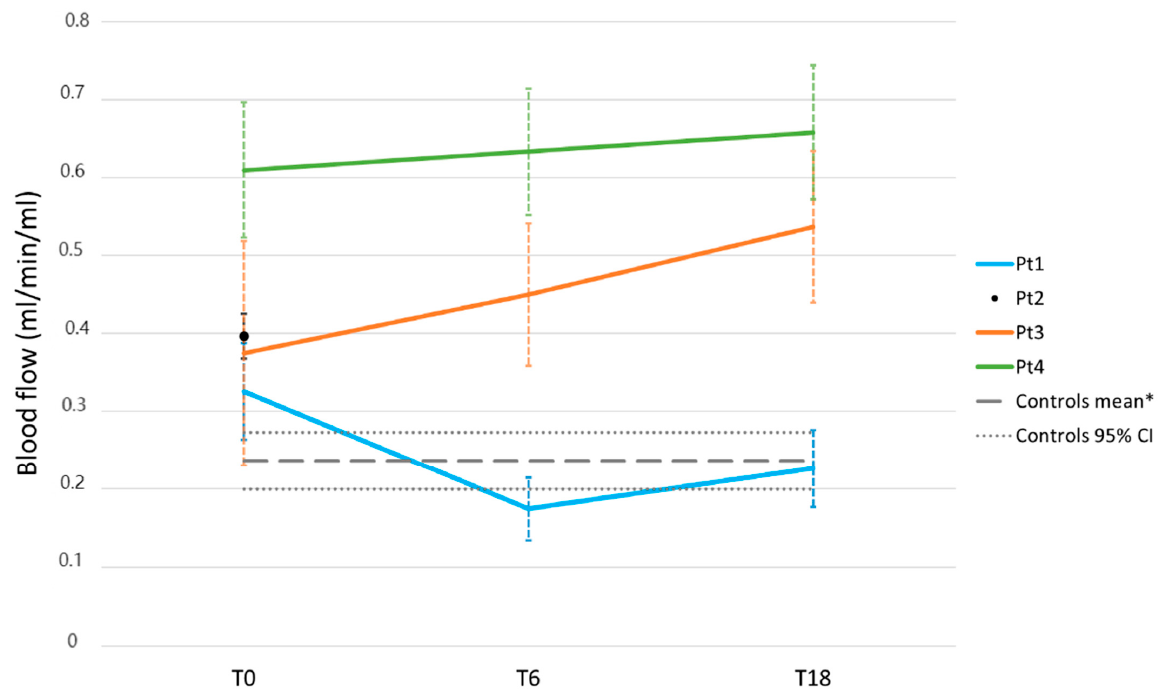
Figure 5. Blood flow as measured by [ 15 O]water PET. The mean vertebral blood flow (+/–SD) across the three vertebrae (Th5, Th7, and Th9) is represented by the horizontal lines. Vertical dashed lines represent the standard deviation of the mean of the measured values in the three individual vertebrae.* Obviously, healthy controls were examined at baseline only, yielding a mean value across controls with a 95% confidence interval. These results were extrapolated for later time points.